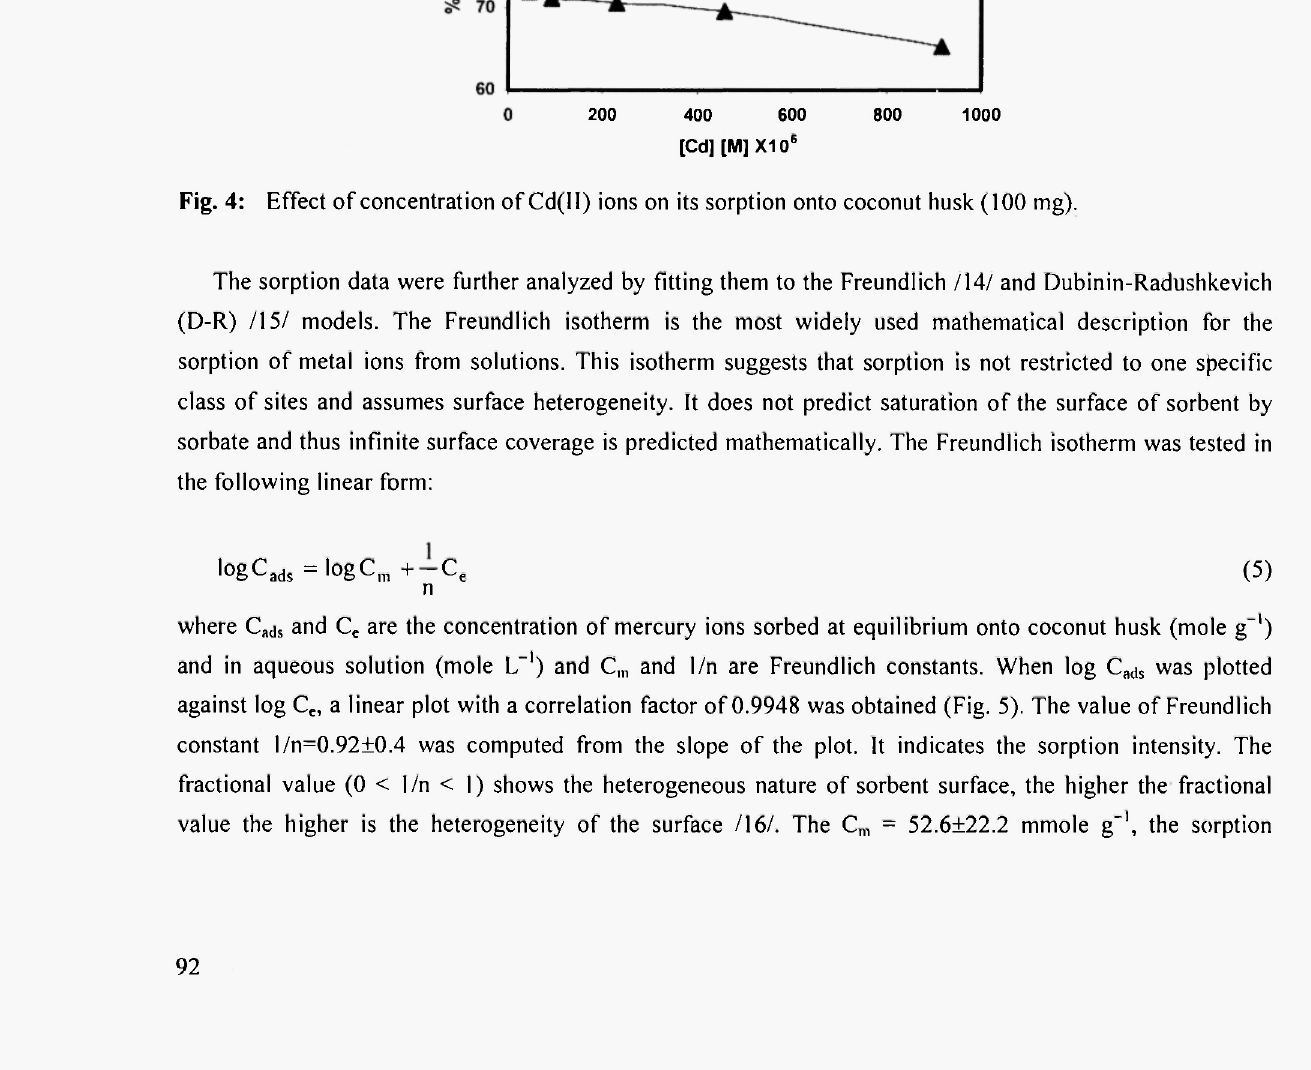
Fig. 4: Effect of concentration of Cd(II) ions on its sorption onto coconut husk (100